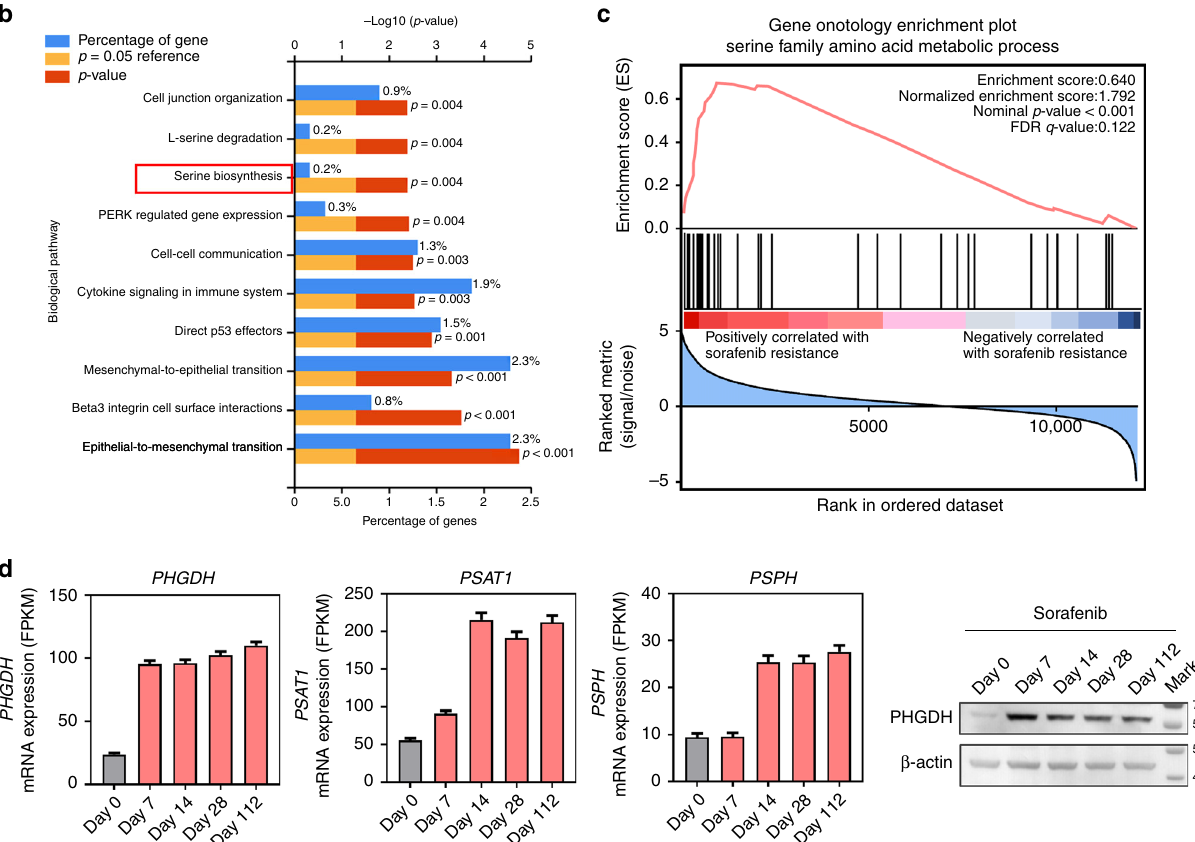
Fig. 2 Activation of serine synthesis pathway was involved in Sorafenib resistance. a MHCC97L cells were treated with Sorafenib for 112 days. RNA-Seq was performed in Sorafenib treated MHCC97L cells at the indicated time points. b DAVID gene ontology and c Gene Set Enrichment Analysis (GSEA) showed that genes involved in serine biosynthesis were signi fi cantly deregulated in Sorafenib-resistant cells (Day 112) when compare to the parental cells (Day 0). d RNA-Seq analysis revealed that the key enzymes in serine synthesis pathway, PHGDH, PSAT1 (phosphoserine aminotransferase 1), and PSPH (phosphoserine phosphatase), were all up-regulated in Sorafenib-resistant cells. The upregulation of PHGDH was also con fi rmed in protein level by western blot. The error bar represents the mean with upper and lower limit. Source data are provided as a Source Data fi